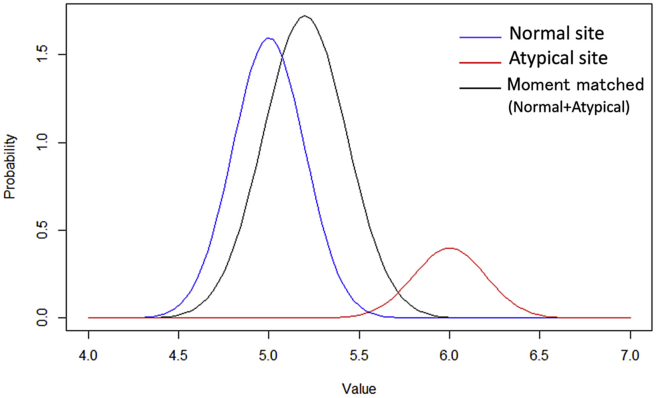
The patient outcome distributions for the case of contaminating data with 20% atypical site data.